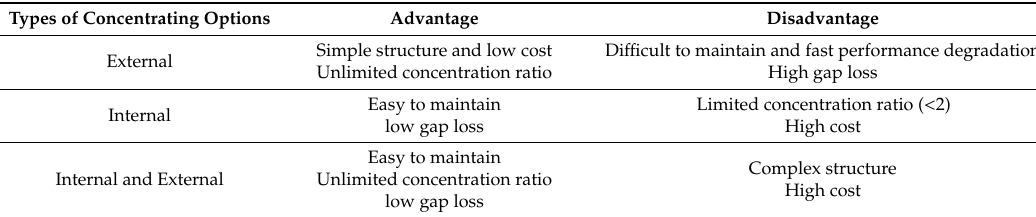
Table 4. Comparison of different types of concentrating options for tubular absorber CPC.